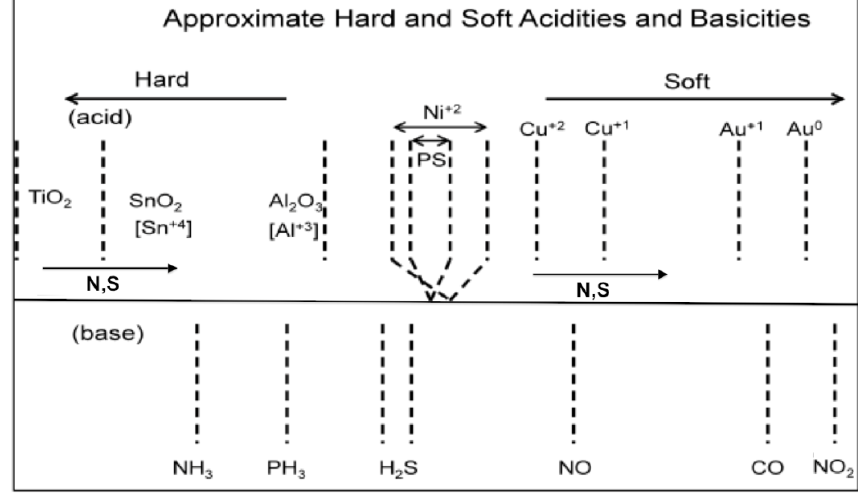
Figure 2. Estimated hard and soft acidities and basicities based on resistance change relative to a p - and n -type porous silicon interface. The acidic metal oxides that decorate the semiconductor interface can be modified through in situ nitridation and sulfurization, decreasing their Lewis acidity. The analytes remain as positioned. A horizontal line is used to separate the metal oxides used to modify the interface (above) and the analytes below in the